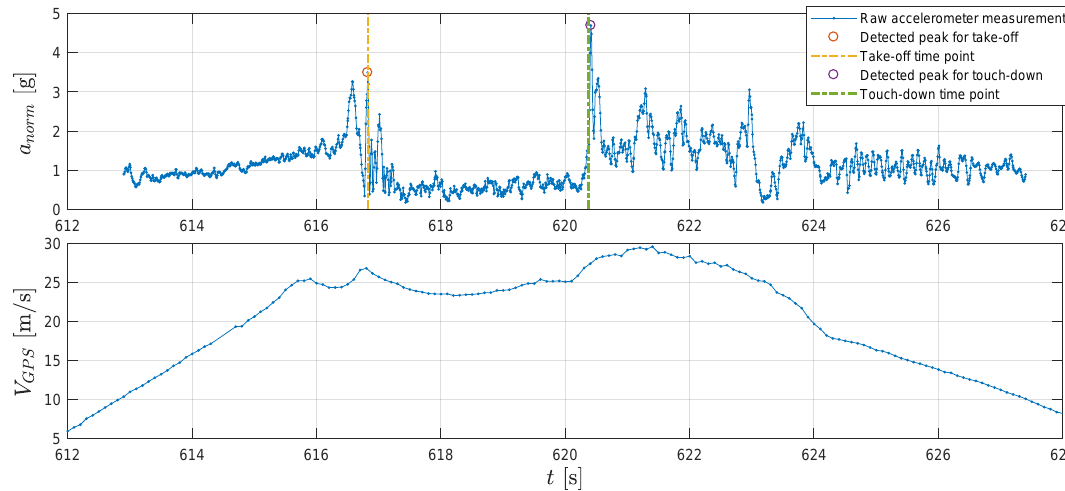
Figure A1. An illustrative example on detecting the take-off and touch-down time points by the raw measurement